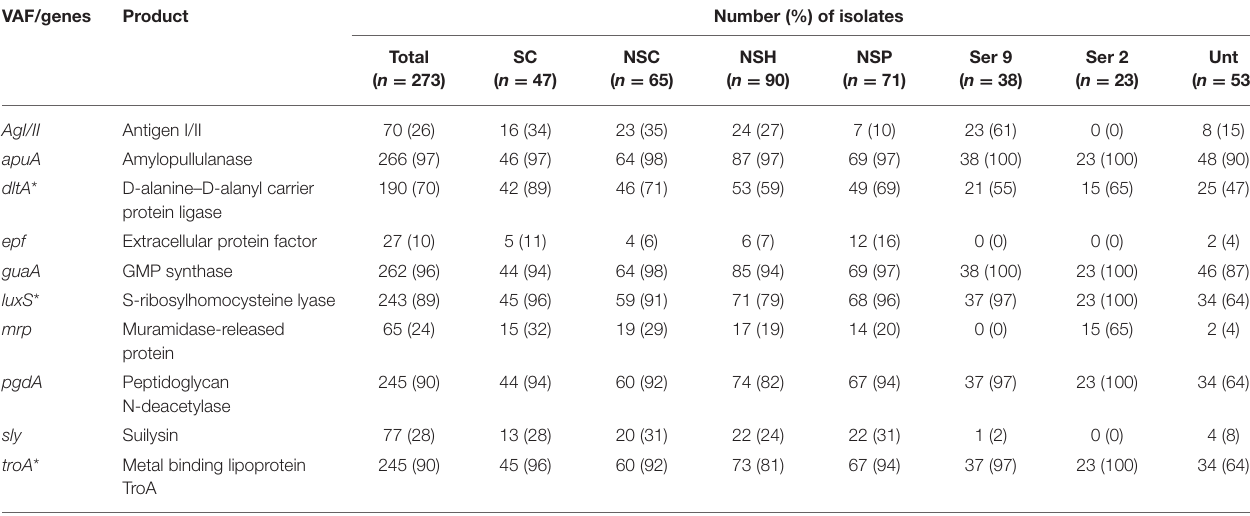
TABLE 2 | Distribution of individual virulence-associated factor (VAF) genes in 273 S. suis isolates in SC, NSC, NSP, and NSH